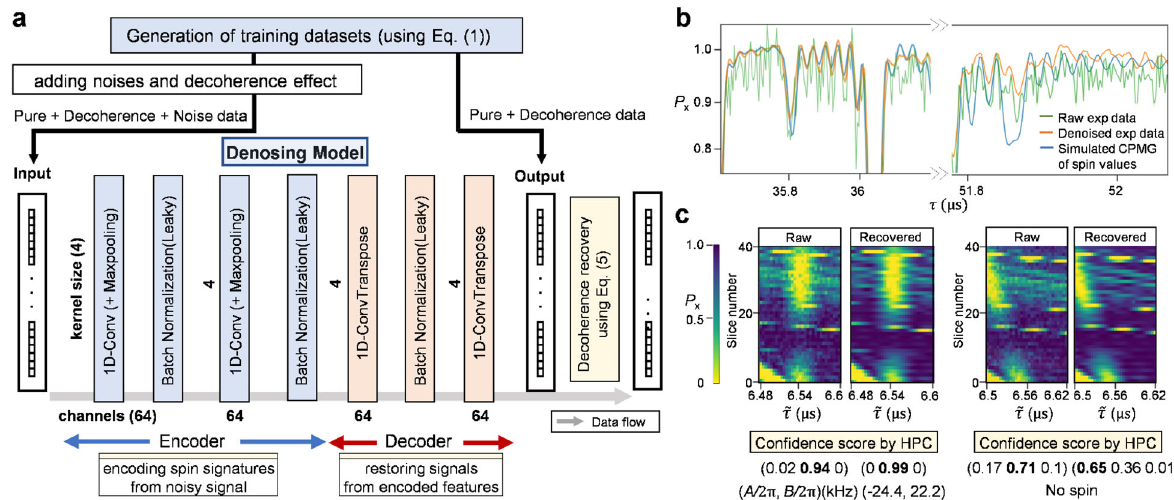
Fig. 3 Denoising and decoherence effect recovery procedure. a Architecture of the signal recovery model. The pure data is generated by Eq. (1). The noisy data is generated by adding decoherence effects and noise to the pure data using Eq. (5). The model is trained to reproduce denoised data from the noisy data and the decoherence effect is recovered using Eq. (5). b Raw experimental (green), pure (blue), and recovered (orange) CPMG data showing successful recovery of the fringe patterns in the presence of noise with a comparable amplitude. The fi gure also shows signal recovery performance in the long evolution time regime. c The comparison of the raw experimental data with the noise recovered data in image representation used for the HPC model, showing an enhancement in signal-to-noise ratio and predictability. The color scale bar in all 2D images ranges from 0 to